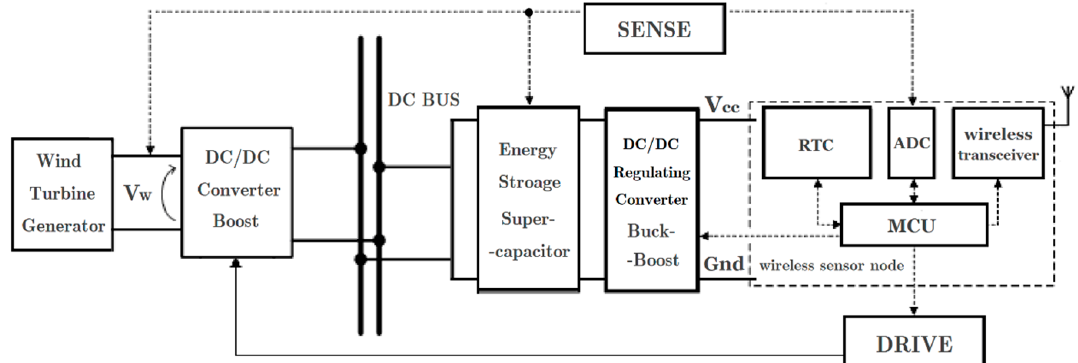
Figure 1. Block diagram of the proposed Energy Harvesting (EH)-node.